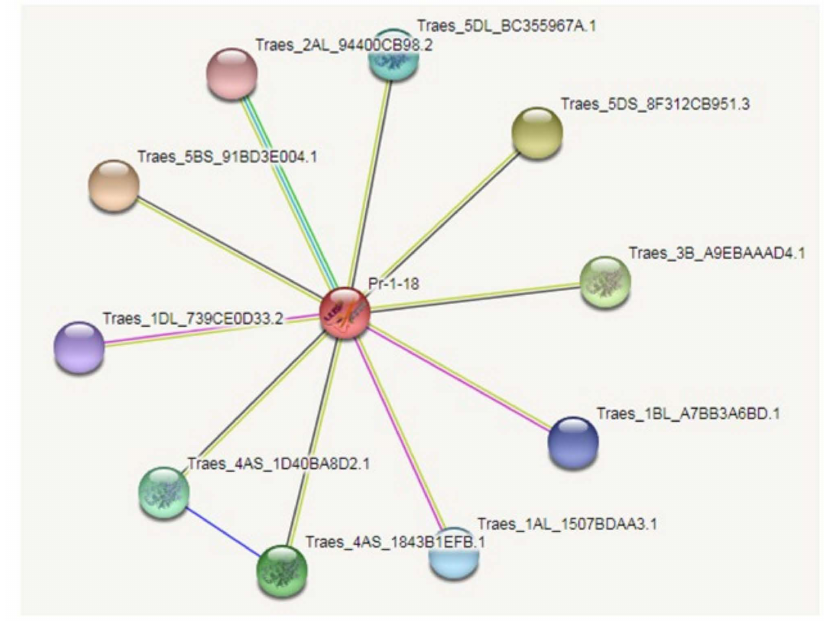
Figure 4. Protein–protein interaction network of AvPR-1